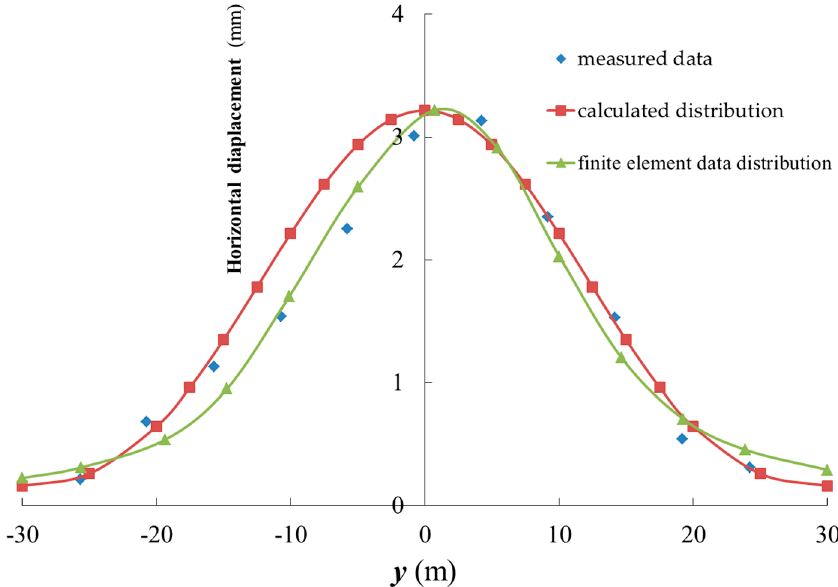
Figure 6. Comparison of the compensated level of horizontal displacement of the tunnel calculated by the proposed method with that by the measured data.